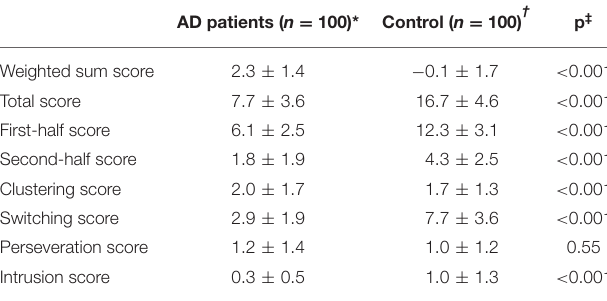
TABLE 3 | Performances on the semi-automatically administered categorical verbal fluency test.